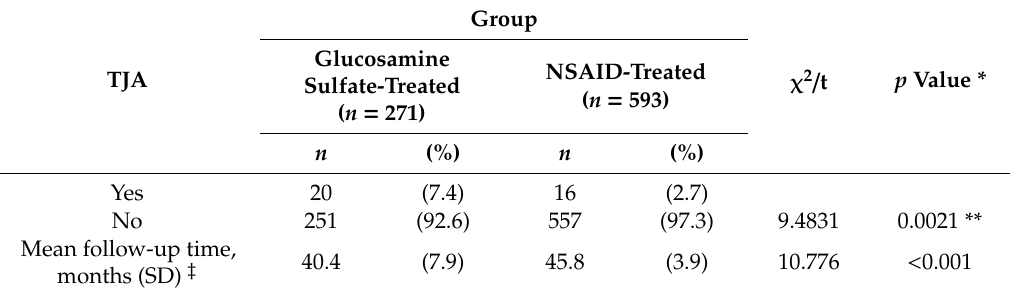
Table 3. The number of patients with osteoarthritis who received and did not receive glucosamine sulfate treatment and the number of patients who underwent total joint arthroplasty (TJA) at follow-up. Group *Glucosamine TJA χ 2 / t p Value